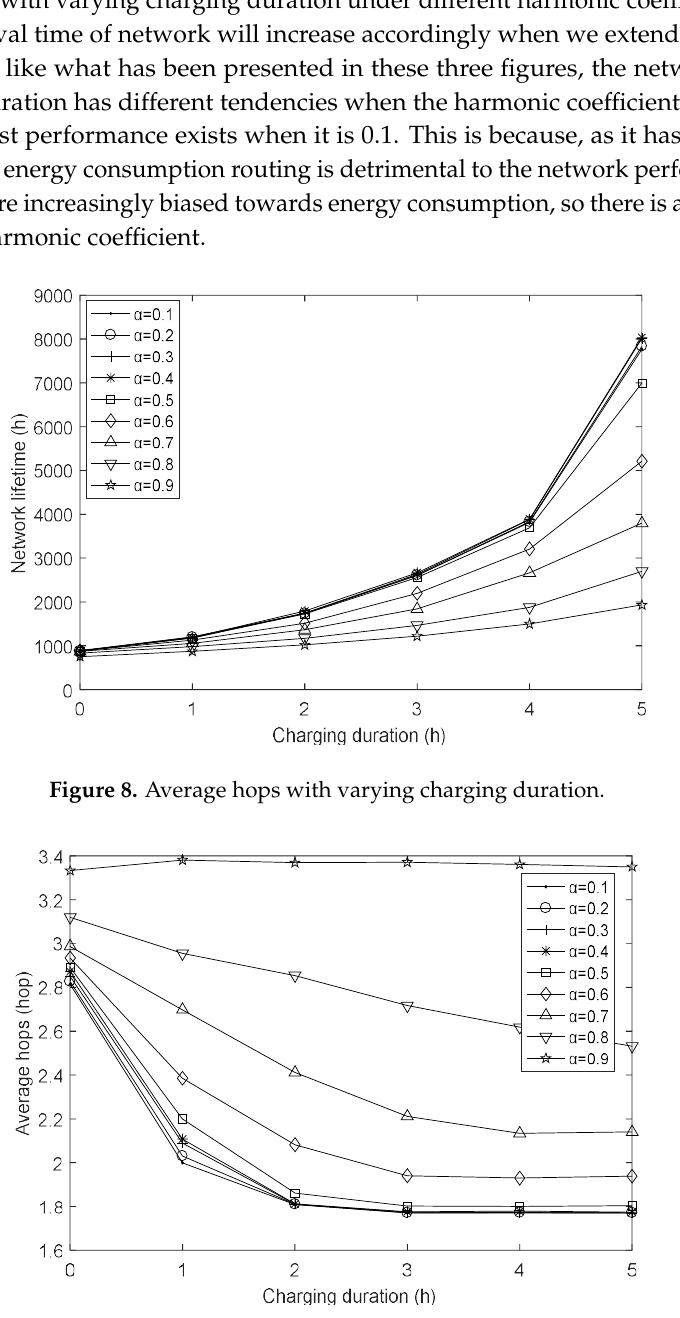
Figure 9. Average hops with varying charging duration.